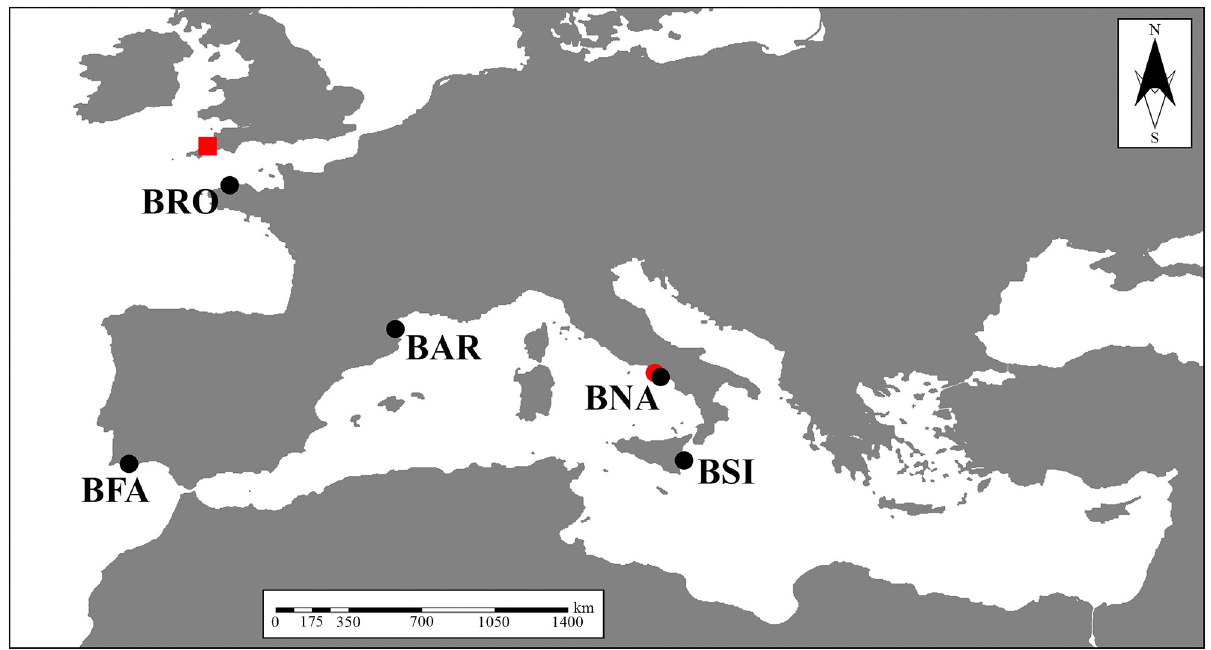
Fig 1. Map of the sampling sites (codes correspond to the localities reported in Table 1) highlighting the type localities of Limax lanceolatus Pallas, 1774 (red square) and Branchiostoma lubricum Costa, 1834 (red circle).